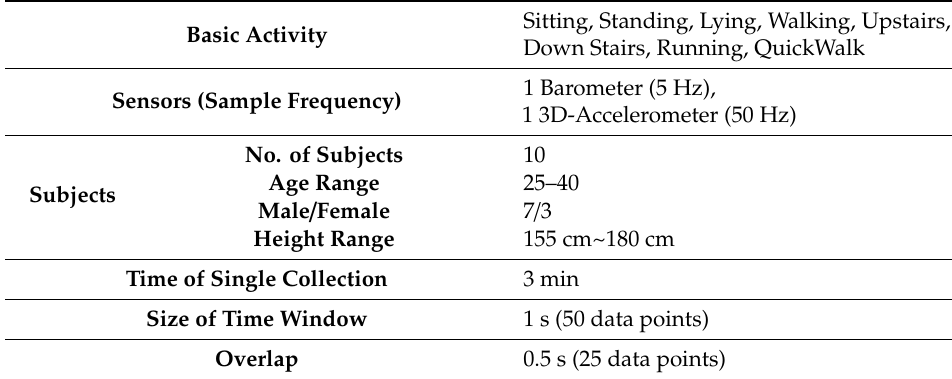
Table 1. Information of our